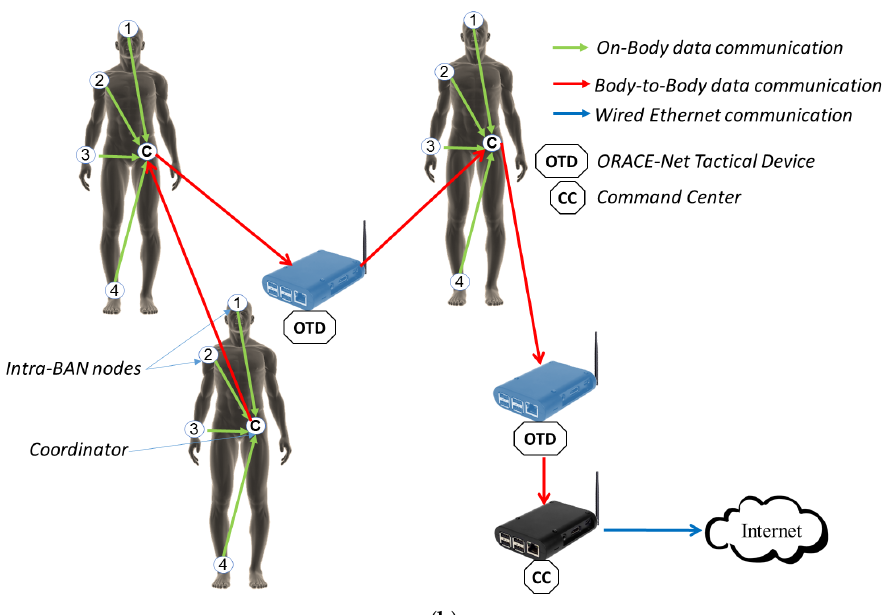
Figure 2. ( a ) CROW 2 system layer-based architecture. BT: Bluetooth, ZB: ZigBee, WF: WiFi, WB: WBAN. For the CROW 2 system, we considered Bluetooth between sensors and the coordinator and WiFi IEEE802.11n between WBANs and the Command Center node (CC node). ( b ) Multi-hop aspect in CROW 2 ; Data are routed from/through mobile/tactical nodes towards the Internet. MQTT, Message Queuing Telemetry